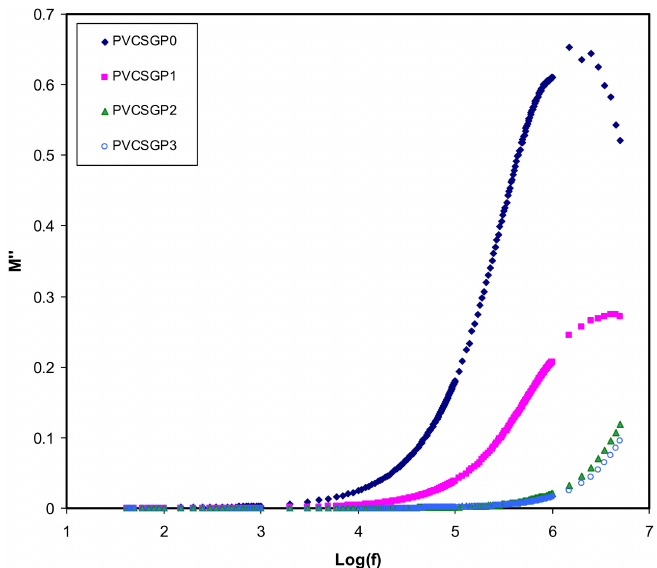
Figure 6. Real part of electric modulus versus log (f) for all polymer-blend electrolytes.